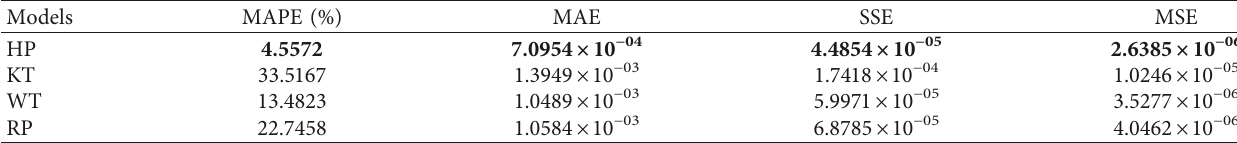
Table 4: Goodness-of-fit measures in fitting the men’s mortality rate.